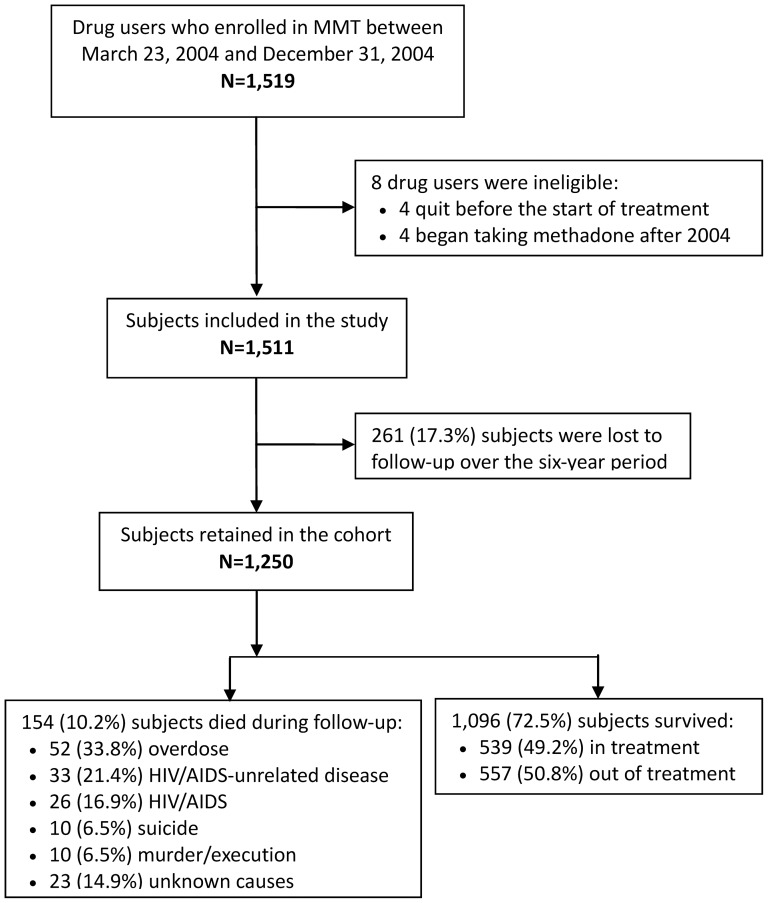
Flow diagram depicting the development of the study cohort as well as causes of death for deceased subjects and in- or out-of-treatment status for surviving subjects.